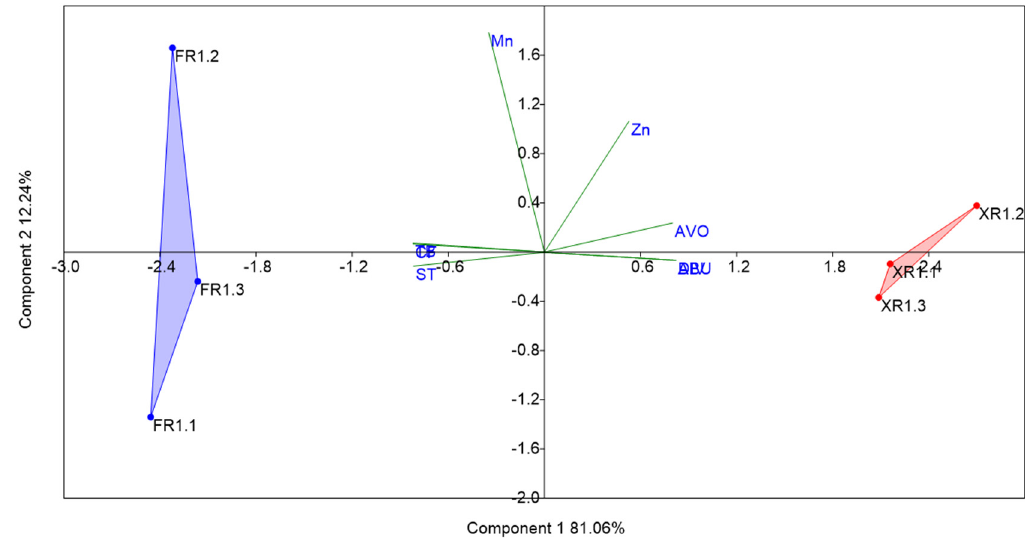
Figure 3. PCA components plot (based on the correlation matrix) for the waters of the Xingu River (XR) and the Fresco River (FR), considering the following variables: Mn, Zn, avoidance (AVO), total solids (TS), turbidity (TB), area with forest (FOR), aquatic invertebrate abundance (ABU), and aquatic invertebrate diversity (DIV).